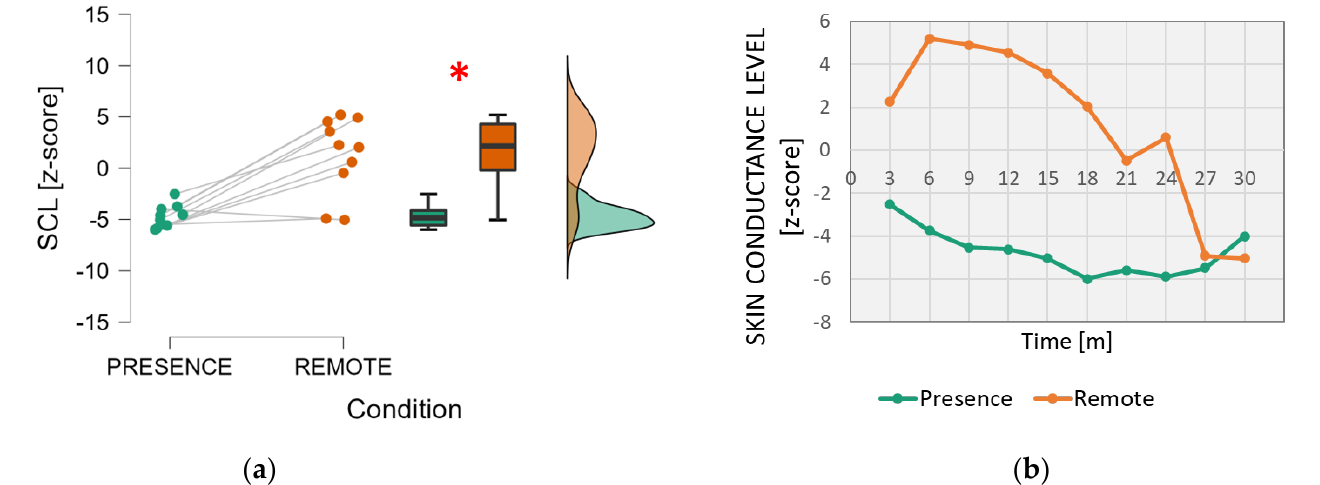
Figure 6. Analysis of the electrodermal activity, particularly the Skin Conductance Level. On the left ( a ), mean and confidence interval (95%) of the distributions related to the two conditions (In-presence and Remote). The red asterisk indicates the presence of a statistically significant effect. On the right ( b ), the dynamics of the SCL parameter averaged across students during the time span of the lesson. The red asterisk indicates the statistically significant ( p < 0.05) result.